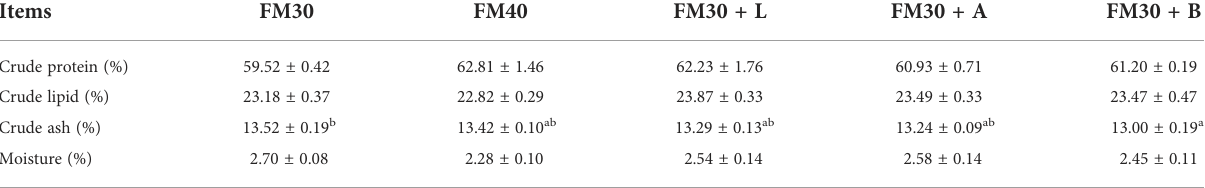
Values marked with different letters are signi fi cantly different (P < 0.05) between treatments.